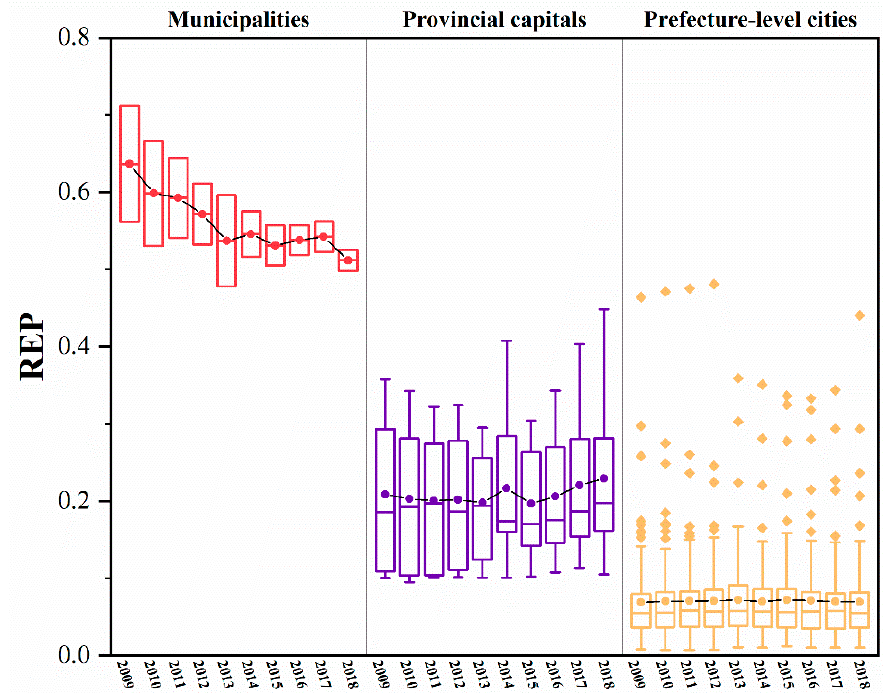
Figure 6. REP index of cities at different administrative levels in 2009 and 2018.